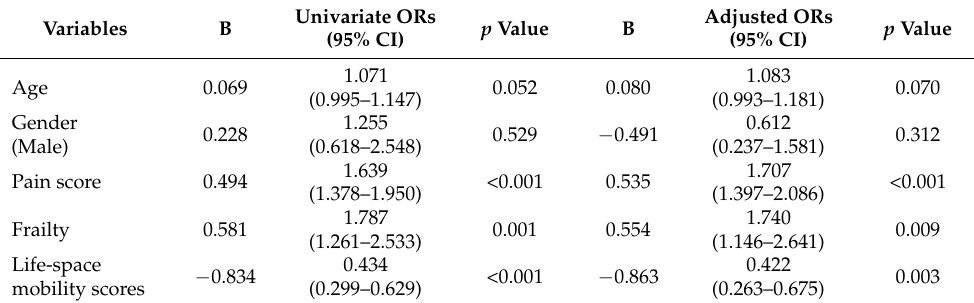
Table 3. Multiple logistic regression analysis among frailty, life-space mobility, and patient-reported outcomes of disability (N = 165).